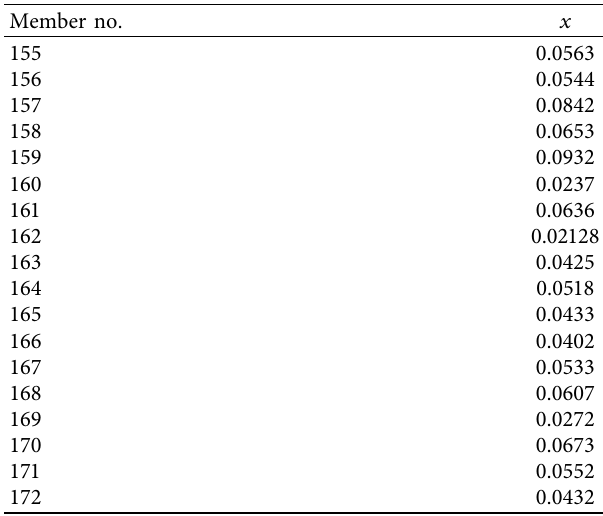
Table 3: Damage identification results of working condition 2